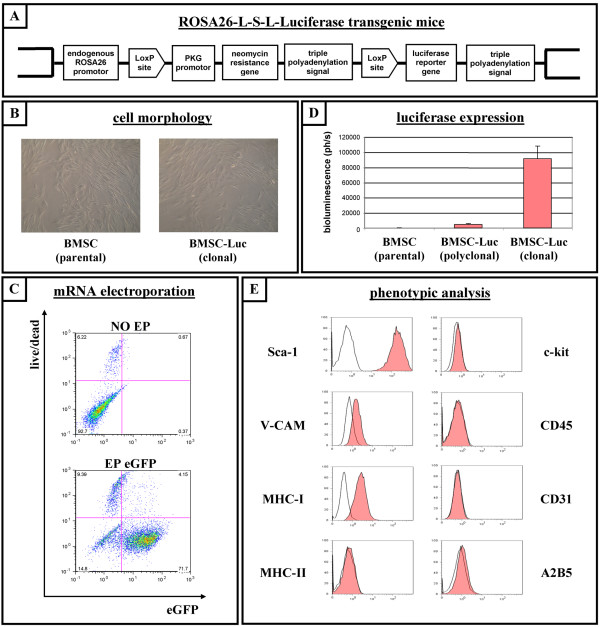
Culture and characterisation of a clonal luciferase-expressing bone marrow-derived stromal cell line from ROSA26-L-S-L-Luciferase transgenic mice. (A) Molecular organisation of the ROSA26 locus in ROSA26-L-S-L-Luciferase transgenic mice. (B) Representative pictures of cultured bone marrow-derived stromal cells (BMSC) taken under phase contrast microscopy. Left: unmodified parental BMSC derived from ROSA26-L-S-L-Luciferase transgenic mice (BMSC parental). Right: clonal luciferase-expressing BMSC derived from ROSA26-L-S-L-Luciferase transgenic mice (BMSC-Luc clonal). (C) Parental BMSC derived from ROSA26-L-S-L-Luciferase transgenic mice were non-electroporated (NO EP, upper dot plot) or electroporated with eGFP mRNA (EP eGFP, lower dot plot), and were analyzed by flow cytometry for eGFP fluorescence (x-axis) versus viability (GelRed-staining, y-axis) after 24 hours of culture. The percentage indicated in the lower left quadrant is the number of viable eGFP-negative cells. The percentage indicated in the lower right quadrant is the number of viable eGFP-positive cells. The percentages indicated in the upper left and right quadrant are numbers of non-viable cells. Representative dot plots are shown. (D) In vitro luminescence assay on parental BMSC (BMSC parental), on Cre-recombined polyclonal luciferase-expressing BMSC (BMSC-Luc polyclonal), and on Cre-recombined clonal luciferase-expressing BMSC (BMSC-Luc clonal), all derived from ROSA26-L-S-L-Luciferase transgenic mice. (E) Representative flow cytometric analysis showing expression pattern of membrane proteins on clonal BMSC-Luc derived from ROSA26-L-S-L-Luciferase transgenic mice (i.e. expression of Sca-1, V-CAM and MHC-I, but no expression of MHC-II, c-kit, CD45, CD31 and A2B5). Open histograms: control. Filled histograms: specific antibody staining.